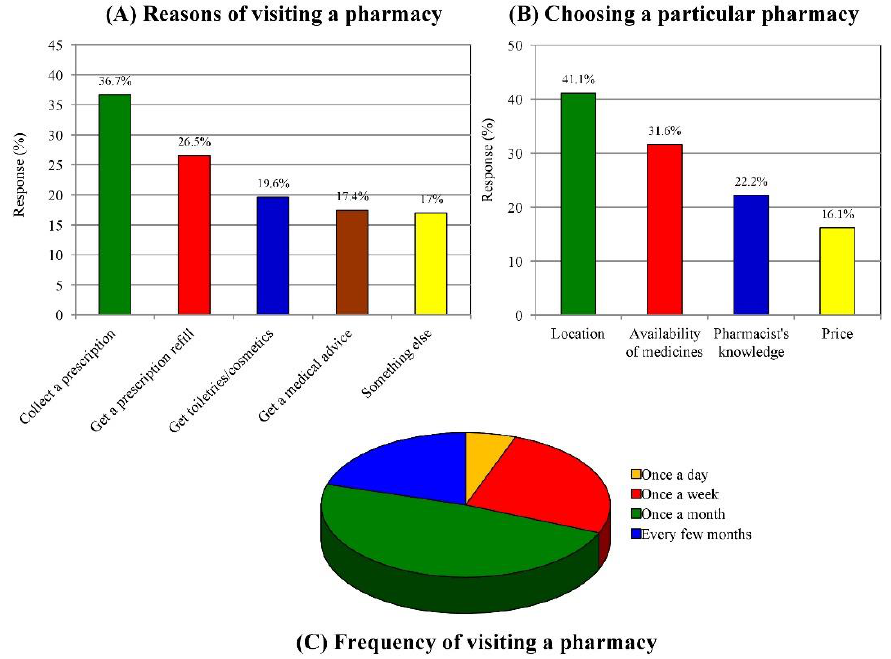
Figure 2. Reasons for visiting the community pharmacy ( A ). Factors contributing to choosing a particular community pharmacy ( B ). Frequency of visiting a pharmacy ( C ).